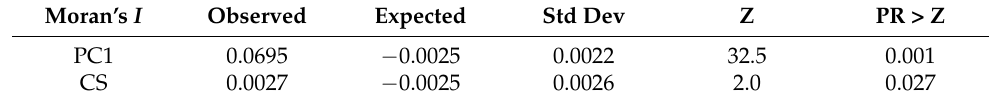
Table 3. Moran’s I results for shape using the first principal component and size using centroid size with reference to geographic location.